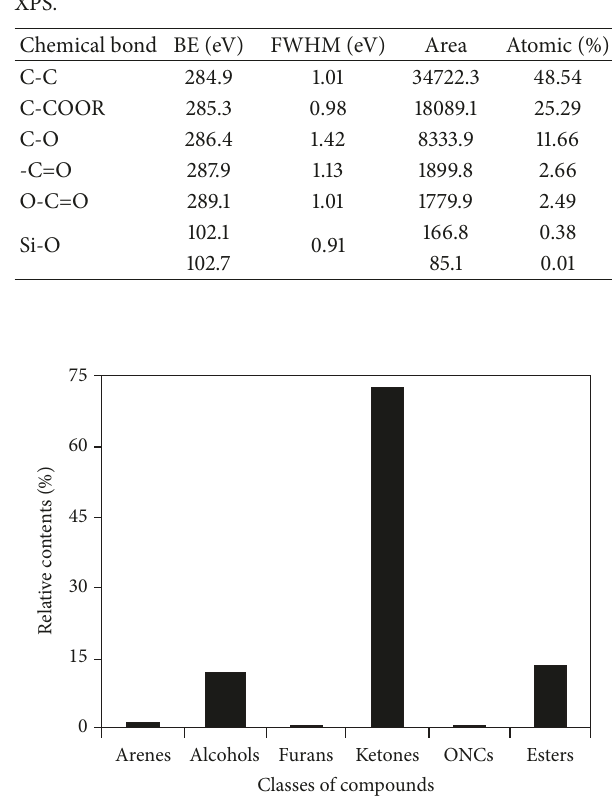
Figure 6: Relative contents of classes of compounds identified in EF CS 2